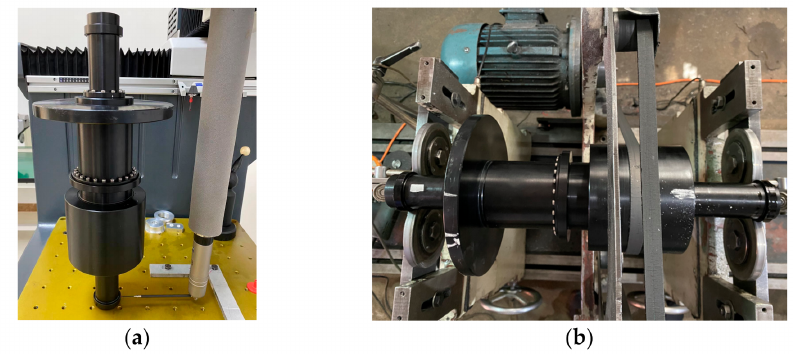
Figure 15. The measurement of the coaxiality and unbalance of the assembled high-pressure rotor system. ( a ) The coaxiality is measured by a 3D coordinate measuring instrument; ( b ) The unbalance is measured by a dynamic balancing machine. Table 6. The measurement results of the coaxiality and unbalance of the assembled high-pressure rotor system.